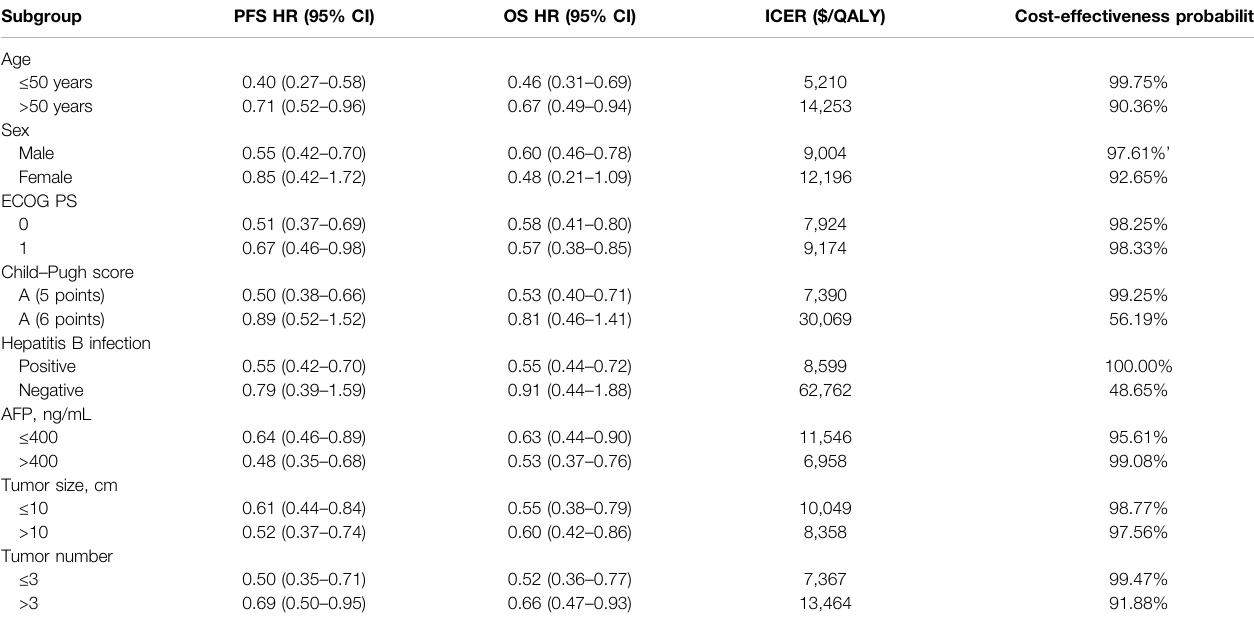
TABLE 3 | Results for subgroup analyses.